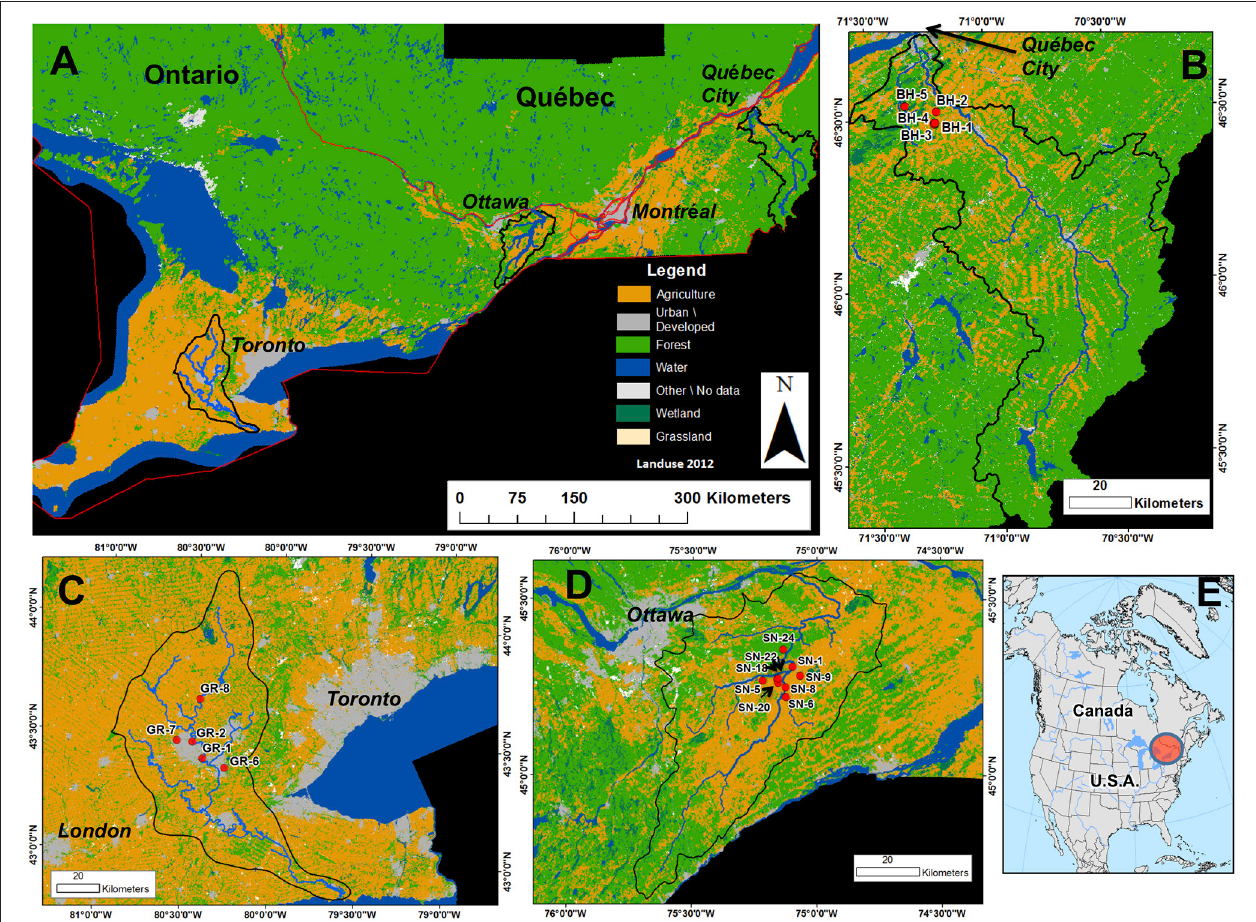
FIGURE 1 | The sampling sites in the current study. (A) Southern Ontario and Québec; (B–D) the sampling sites at (B) the Bras d’Henri (BH) River, (C) the Grand River (GR); and (D) the South Nation River area (SNRA); (E) the relative location of the sampling sites in North